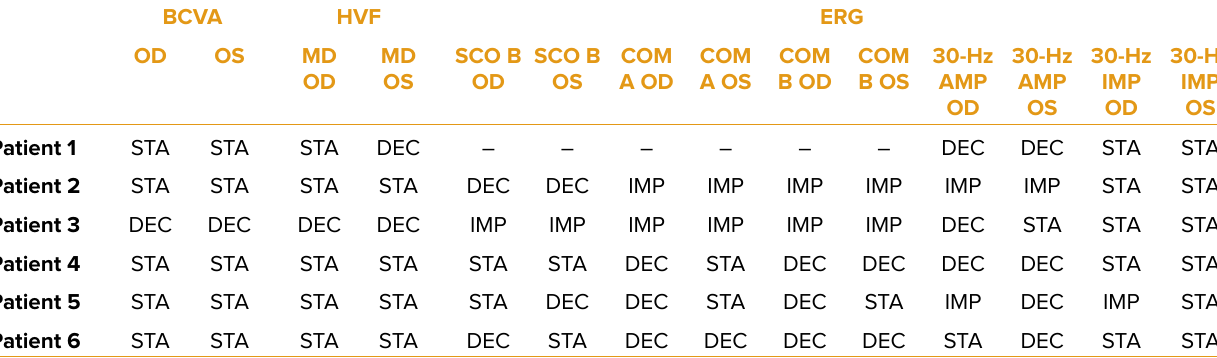
Table 3. Changes in visual function parameters from baseline to twelve-month follow-up visit.